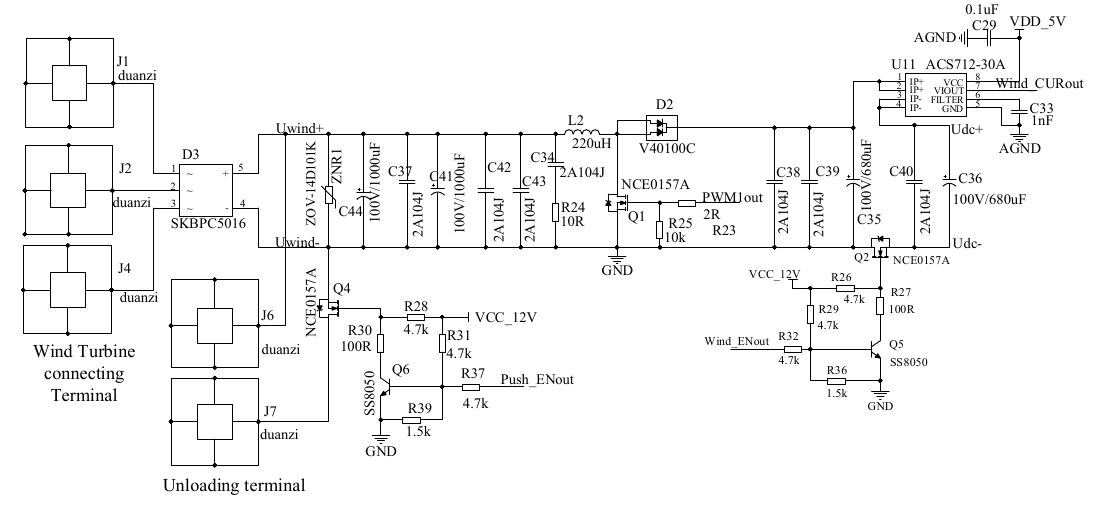
Figure 10. Wind power generation circuit.